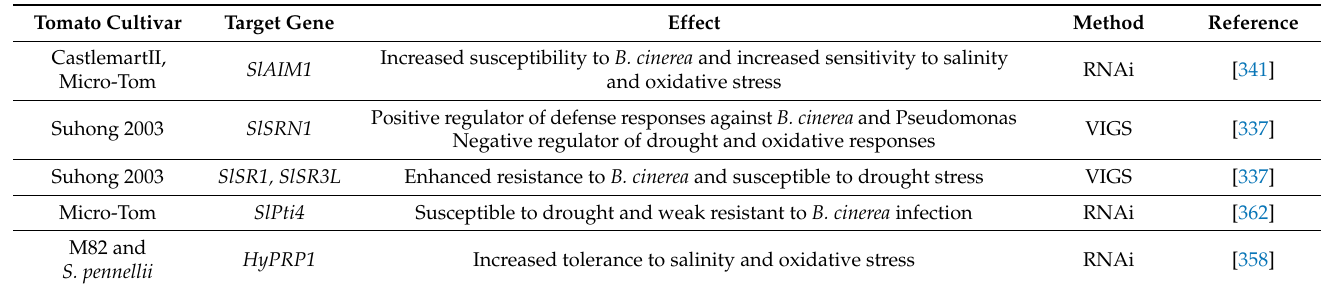
Table 3. Genome editing of tomato cultivars in response to combined biotic and abiotic stresses. Abscisic acid-induced MYB1 (SlAIM1), Hybrid proline-rich protein1 (HyPRP1), Stress-related NAC1 (SlSRN1), Tomato ethylene response factor (SlPti4), Tomato lipoxygenase gene (SlTomLoxD), Tomato SR/CAMTA transcription factors (SlSR1 and SlSR3L). Tomato